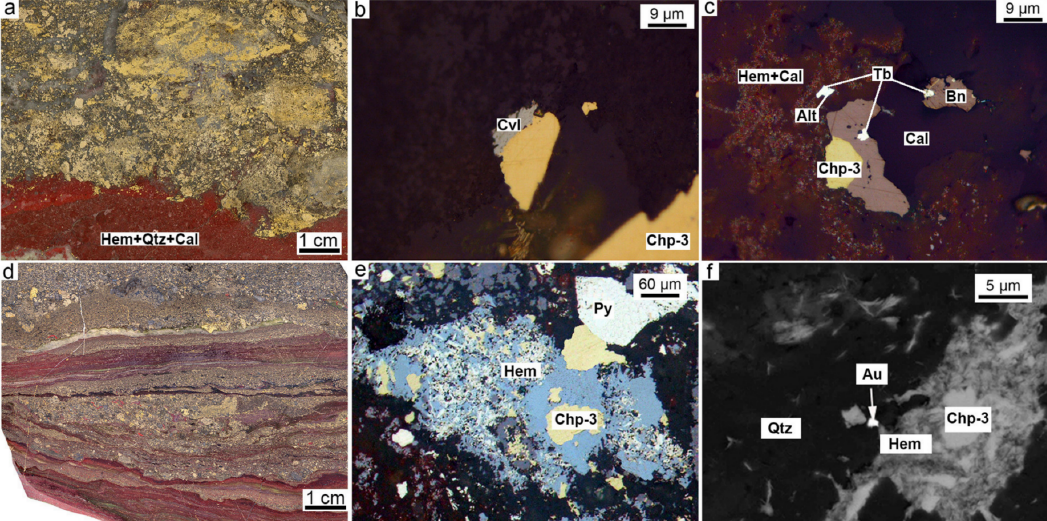
Figure 17. Mineralogical features of gossanites of the Yubileynoe ( a – c ) and Yaman-Kasy ( d – f ) deposits: ( a ) Red quartz–hematite–calcite gossanite and sulfide breccia layers; ( b ) inclusions of cervelleite and chalcopyrite-3 in gossanite; ( c ) inclusions of chalcopyrite- and, bornite in assemblage with tellurobismuthite (tb) and altaite intergrowths; ( d ) intercalation of gossanites with sulfide turbidites; ( e ) relict chalcopyrite-3 in hematite; ( f ) small grain of native gold in quartz near hematite with relict chalcopyrite-3. ( a , d ) Polished samples, ( b , c , e ) reflected light, ( f ) SEM